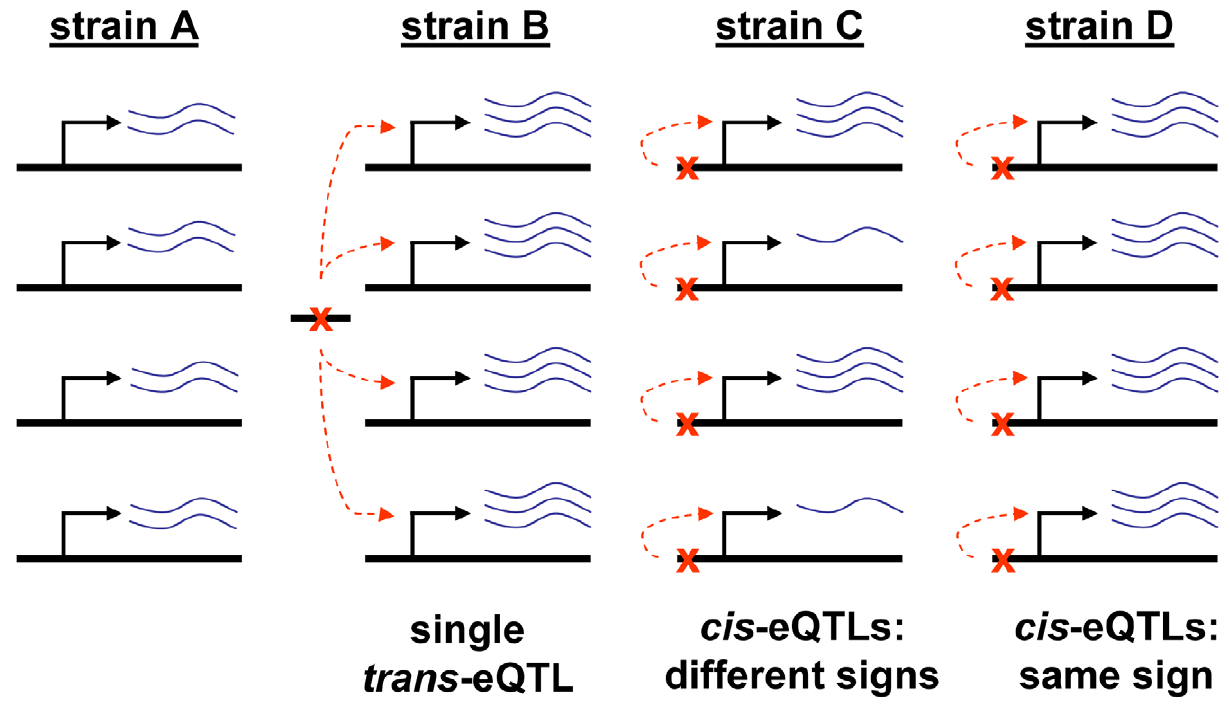
Figure 1. Illustration of our test for lineage-specific selection. Four unlinked genes are shown for each of four strains (or subspecies, species, etc). The number of curved blue lines (mRNA molecules) next to each gene represents its transcript level. Red ‘‘X’’s represent polymorphisms that underlie eQTLs. Comparing strains A versus B, a single trans- eQTL (shown on a fifth chromosome) up-regulates all the genes. Although all four genes show the same direction of expression change, this is not evidence for selection, since the single trans- eQTL could be neutral. Comparing strains A versus C, all four genes have independent cis- eQTLs, but the directions are split between up- and down-regulation; thus there is no evidence for selection here as well. Comparing strains A versus D, again all four genes have independent cis- eQTLs, but now they are all up-regulating. This is consistent with lineage-specific selection for altered expression of this entire gene set (although in practice, more than four genes are needed to achieve statistical